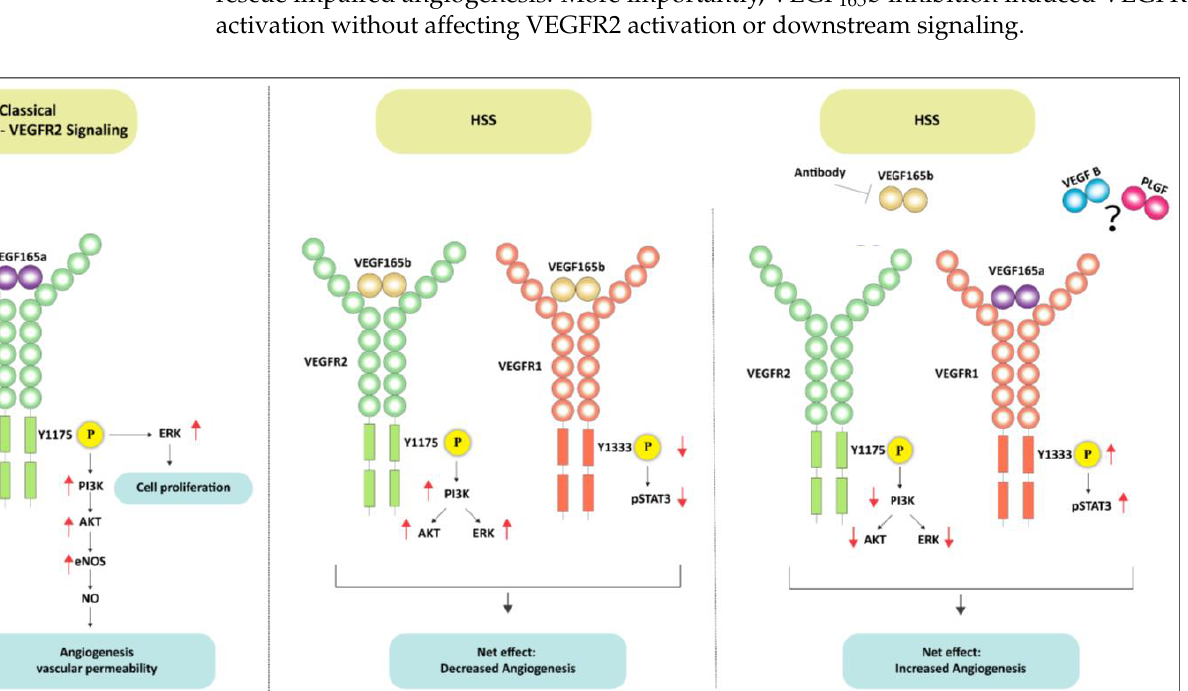
without changes in AKT activation in eNOS-KO ischemic muscle, VEGF 165 b inhibition in